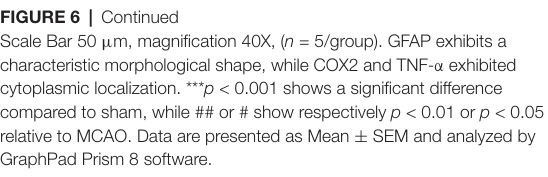
Frontiers in Molecular Neuroscience |